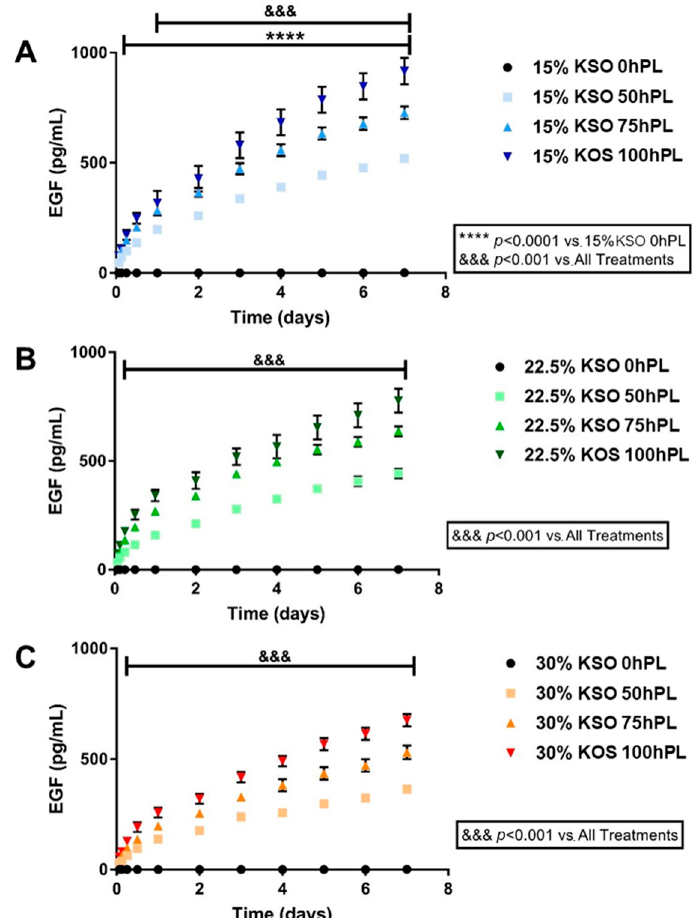
Figure 4. Epidermal growth factor (EGF) release against varying hPL concentrations. EGF release was plotted against varying hPL concentrations for 15% ( A ), 22.5% ( B ), and 30% ( C ) KSO hydrogels over the course of 7 days. For each KSO hydrogel, increase in hPL concentration correlated with increased EGF release. No release was observed with 0 hPL hydrogels for each condition.